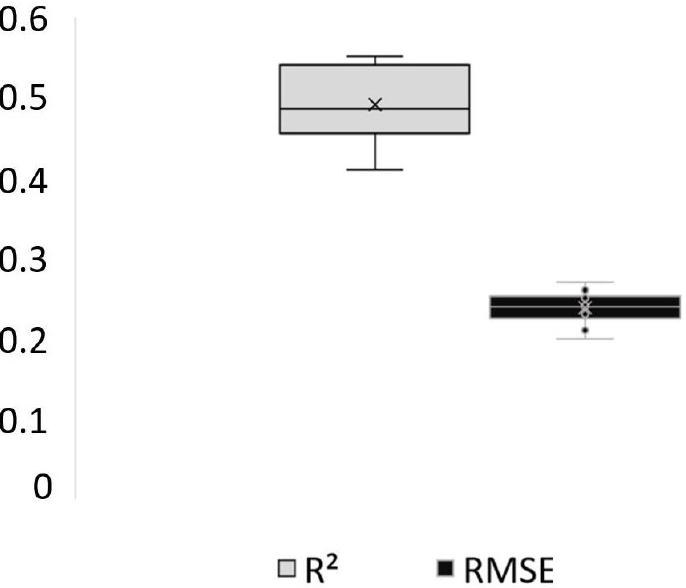
Figure 9. Boxplot of R 2 and RMSE over the 10 split for Linear model with the whole dataset (all years and all inter-row